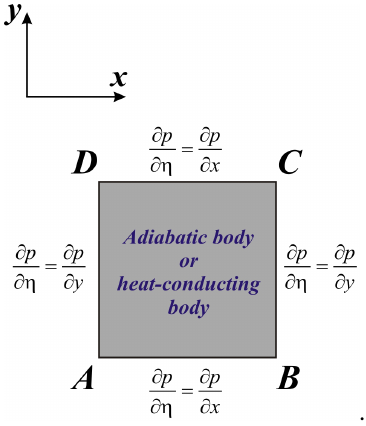
Figure 2. Surface of the internal body.